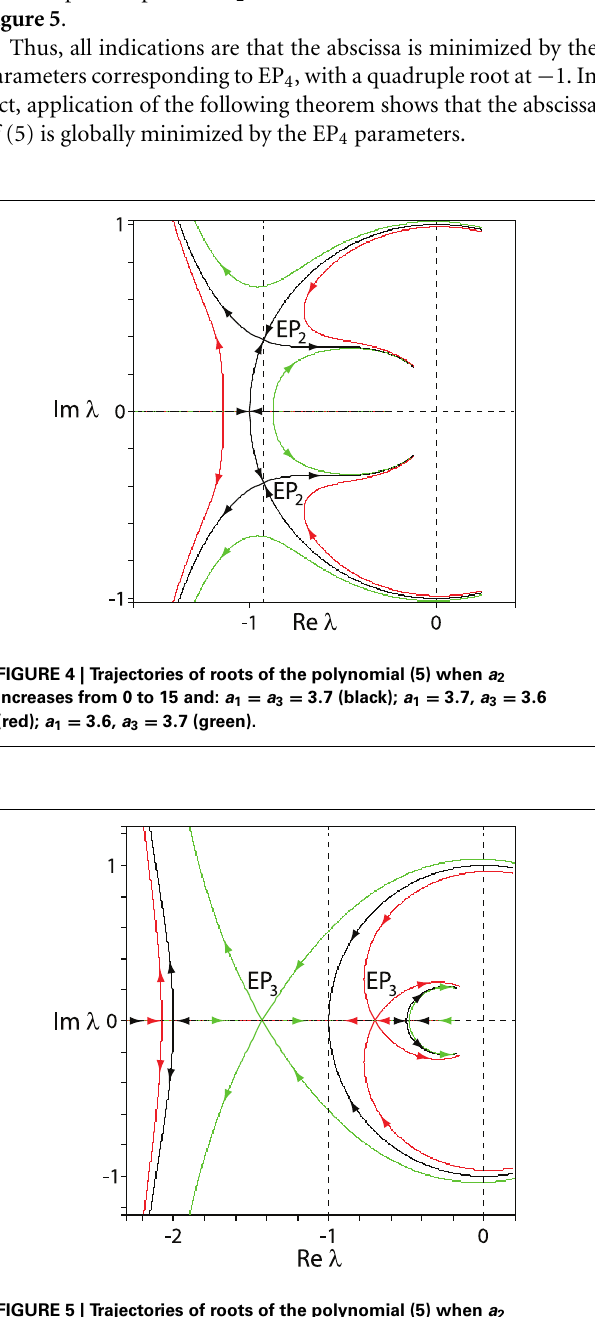
FIGURE 5 | Trajectories of roots of the polynomial (5) when a 2 increases from 0 to 15 and: a 1 = a 3 = 5 (black); a 1 = 5, a 3 ≈ 4 . 621 (red); a 1 ≈ 4 . 621, a 3 = 5 (green), indicating that although three roots coalesce into a triple negative real root (EP 3 ) with Re λ < − 1, there is another simple negative real root with Re λ > − 1.